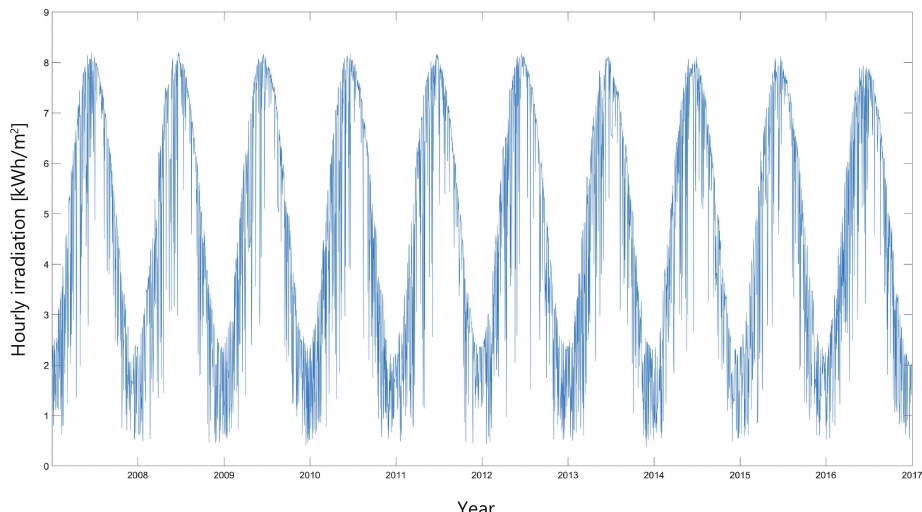
Figure 10. Hourly irradiation (average hourly irradiance) on a horizontal plane on Monte Pagliaro.